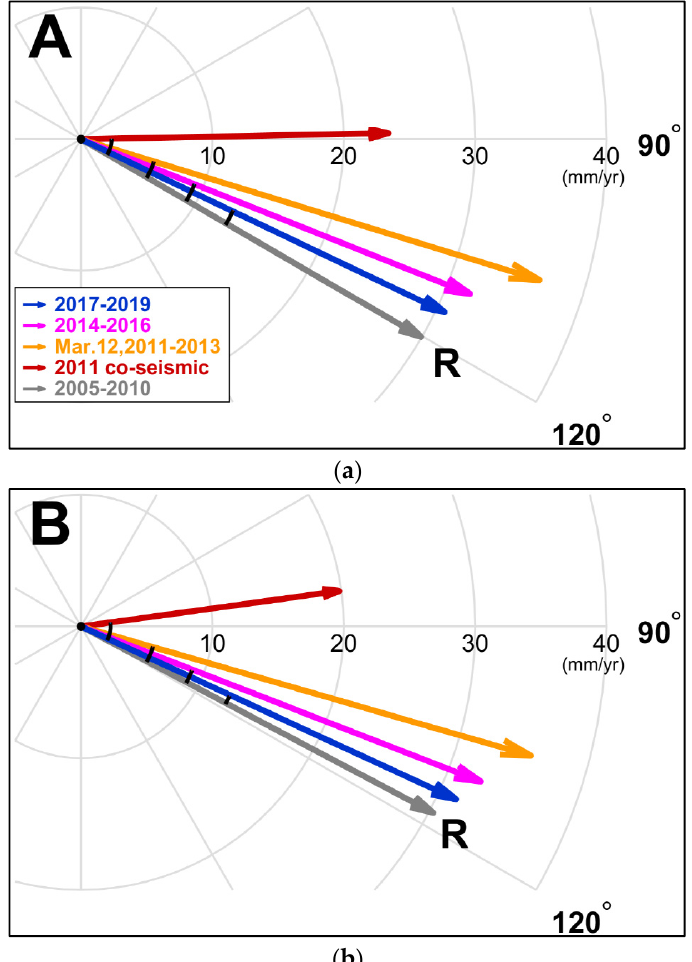
Figure 6. Average velocity vectors of the stations over five periods in the crustal thin ( a ) and thick ( b ) regions corresponding to the two areas ‘A’ and ‘B’ in Figure 5, respectively. The ‘R’ mark represents the pre-earthquake direction as a reference direction. The area ‘B’ with a thick crust shows a faster recovery pattern than the area ‘A’ with a thin crust. Note: In the 2011 co-seismic stage (red arrows), the unit of magnitude is mm. It is a total displacement, not a rate. Table 2. Average velocity direction and difference by referring to the pre-seismic deformation in five periods according to the crustal thickness. The Diff. direction represents the difference angle between the average direction of each stage and the Pre-seismic (‘R’) direction (unit: degrees). Crustal Area